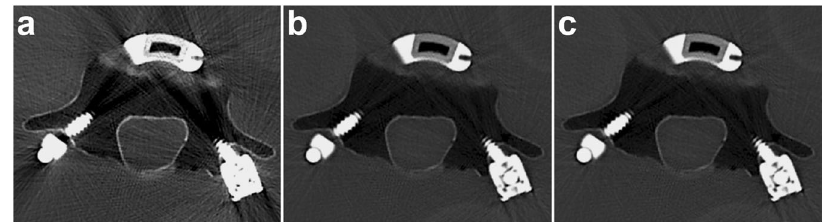
Fig. 4 High energy virtual monochromatic image (VMI) reconstruc- tions allow for artifact reduction. Axial ( a ) 70 keV, ( b ) 100 keV, and ( c ) 140 keV VMIs reconstructed from the same dual-energy CT (DECT) scan are shown. The images are displayed using the same window-level display settings to enable a direct and unbiased com- parison. Note the signi fi cant reduction in artifact and image noise on